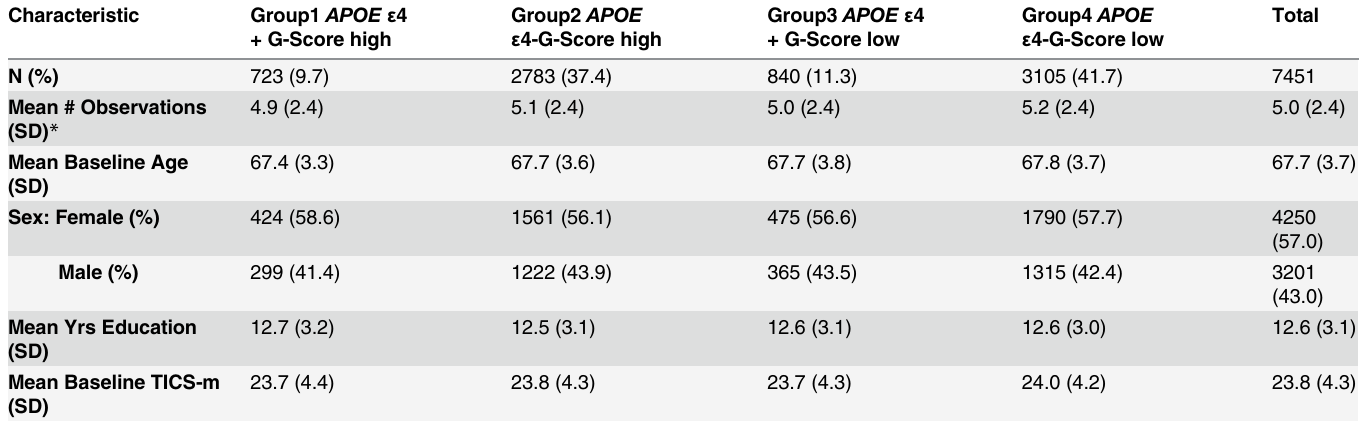
Table 1. Demographic Characteristics of HRS